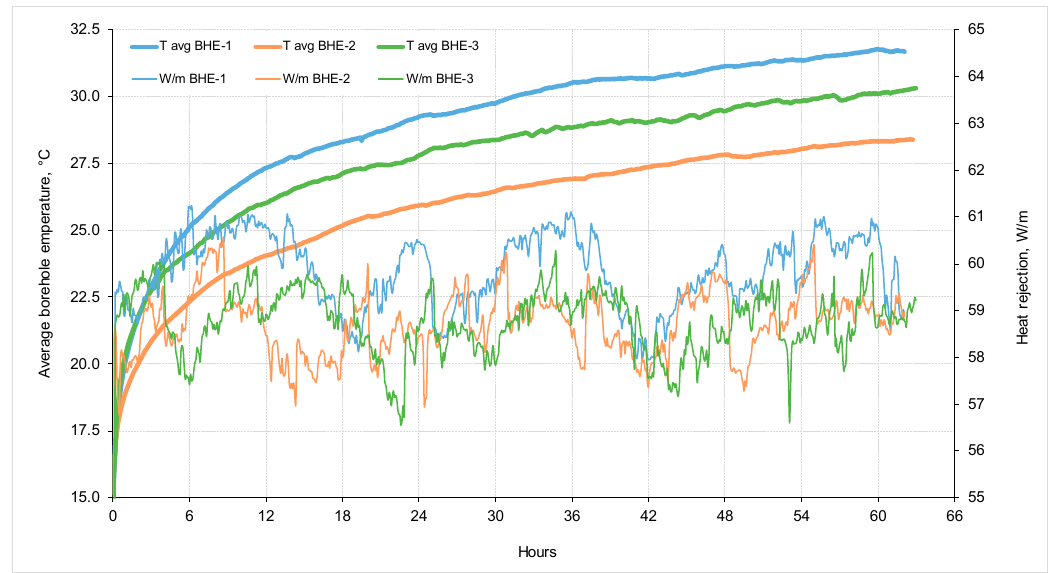
Figure 5. Recorded average fluid temperatures and a power step for a three borehole heat exchangers during TR testing.